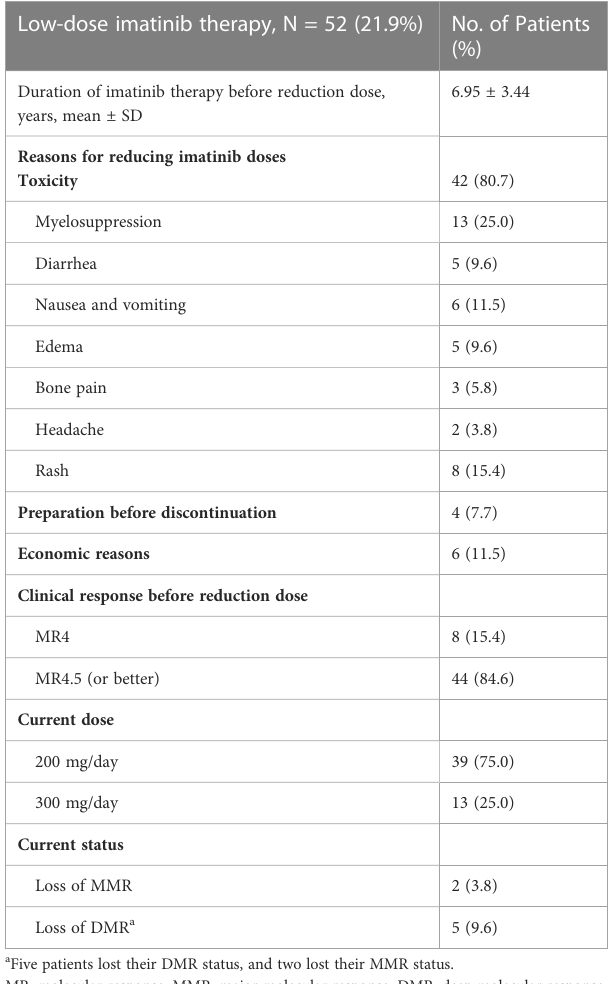
TABLE 4 Low-dose imatinib therapy. Low-dose imatinib therapy, N = 52 (21.9%) No. of Patients